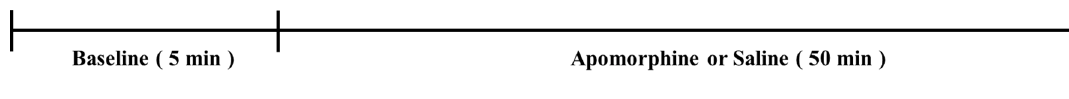
Figure 3. Respiratory challenge protocol.